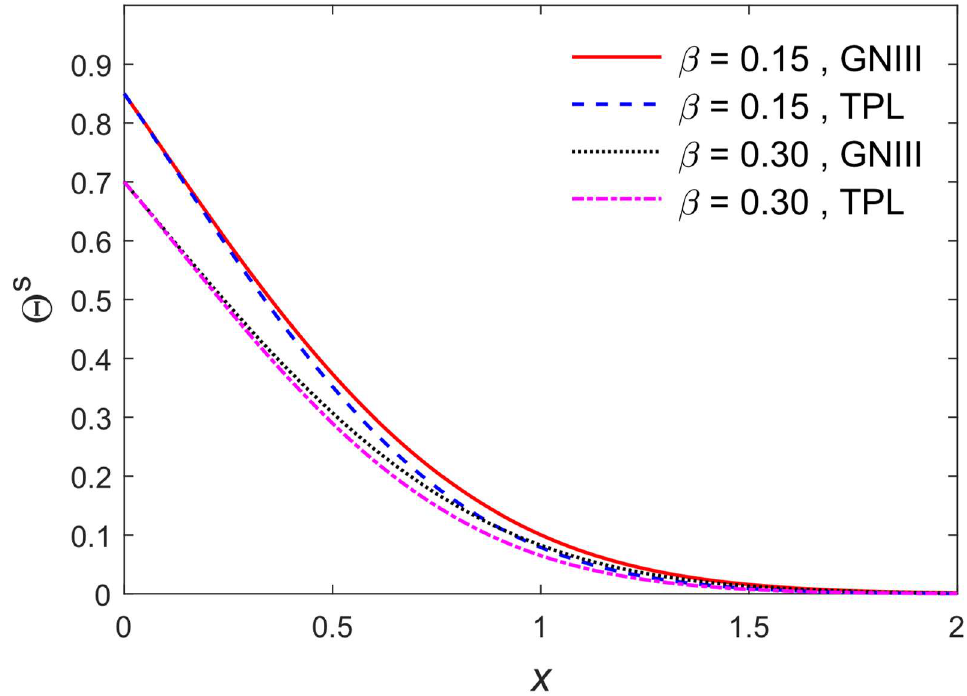
Figure 3. The distributions of fluid displacement U along the distance 𝑥 .